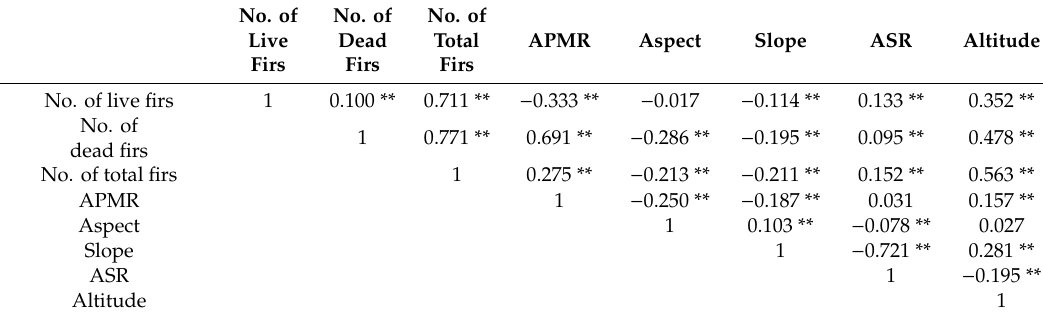
Table 2. Pearson correlation analysis for the investigated distribution features of the Korean fir and topographic